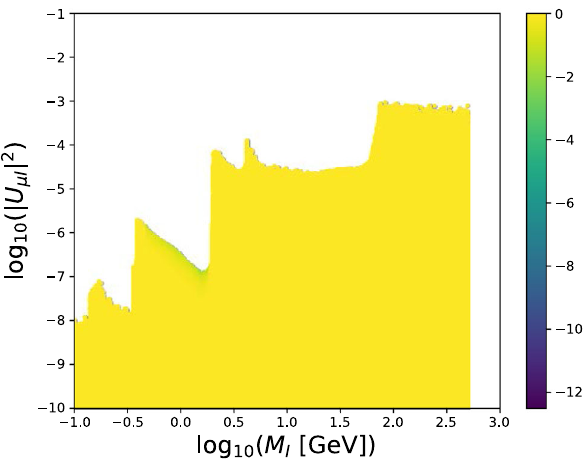
Fig. 30 Partial likelihood from the prompt searches with DELPHI, in the M